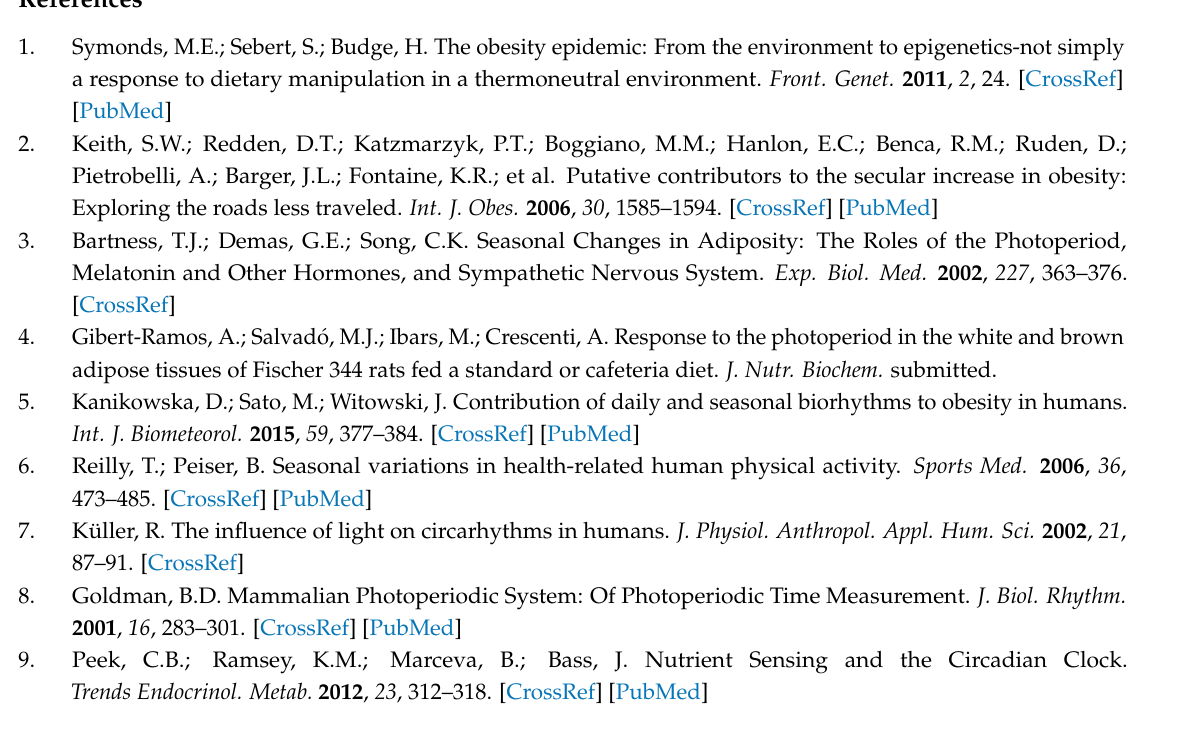
s1, Table S1: Nutritional composition of sweet cherry, Table S2: Phenolic composition of sweet cherry, Table S3: Nutritional composition of the standard and cafeteria diets, Table S4: Primers for the Q-PCR analysis. Author Contributions: Conceptualization, A.G.-R., A.C., and M.J.S.; Data curation, A.G.-R.; Formal